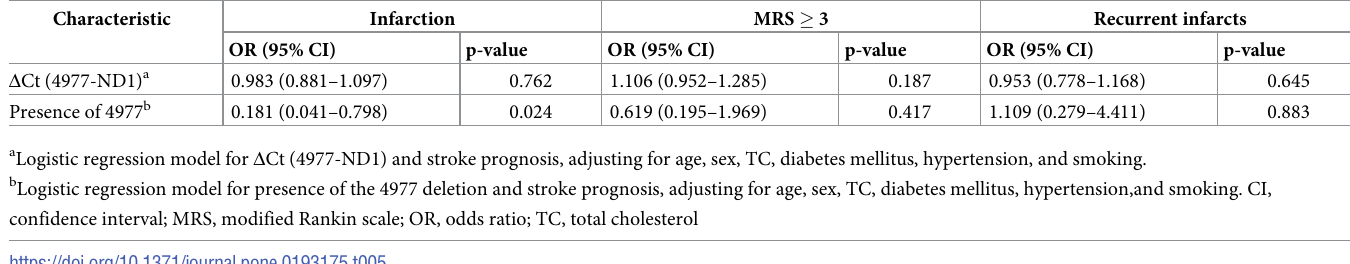
Table 5. Logistic regression models of mt4977 deletion and stroke prognosis.